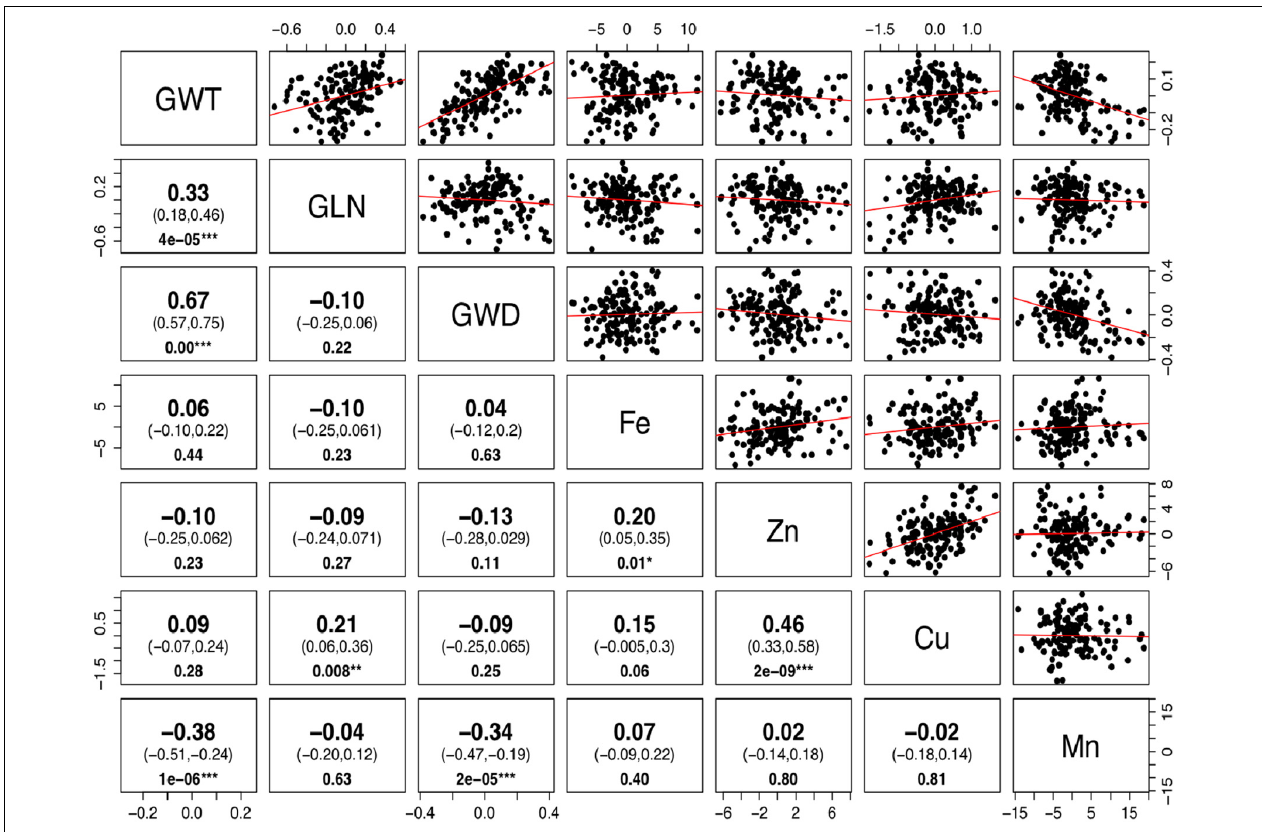
FIGURE 2 | Correlation for grain size and micronutrients concentration in Ae. tauschii accessions. Phenotypic correlations between 50-grain weight (GWT), grain length (GLN), grain width (GWD), iron (Fe), zinc (Zn), copper (Cu), and manganese (Mn) concentrations. The upper and lower 95% confidence intervals are included in parenthesis below the correlation value. P -value for significant correlations is shown at the bottom. (Note: ∗∗∗ , significant at P < 0.001; ∗∗ , significant at P < 0.01; ∗ , significant at P <